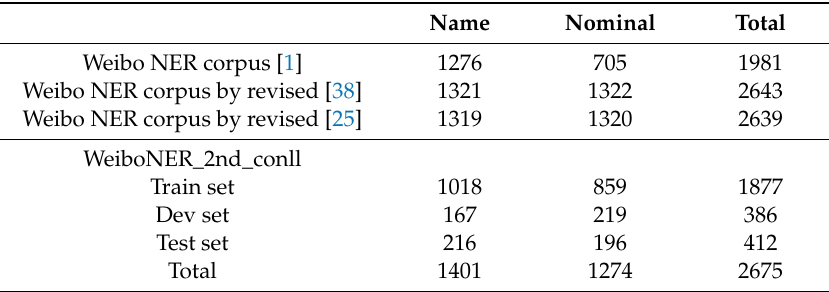
Table 2. Details of Weibo NER